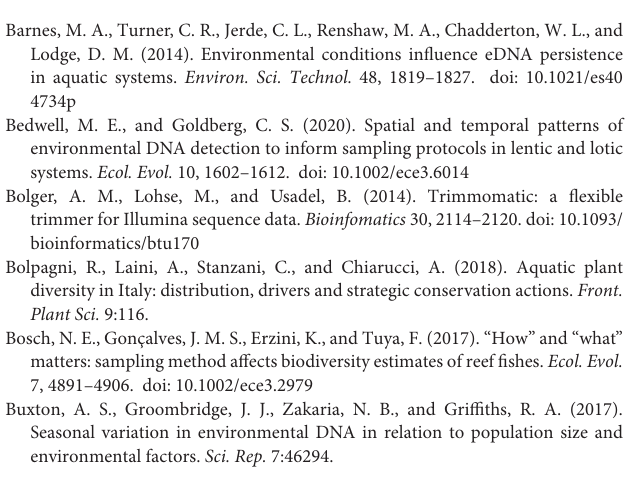
(C) Adapters, second round of PCR. (D) Barcode index sequences. Supplementary Table 2 | Species and sequences used in novel ITS1 primer design. Supplementary Table 3 | Potential false-positive plant taxa. These six records represent the only vascular genera in the eDNA dataset not previously recorded at UNDERC. Supplementary Table 4 | Macrophyte presences by lake. Wetland statuses follow USDA/USACoE conventions, plus an additional category “AQU” for obligate wetland species that are fully aquatic, i.e., floating and submerged macrophytes. Supplementary Table 5 | Phytoplankton presences by lake. Bold/highlighted items are the top ten phytoplankton taxa overall by read